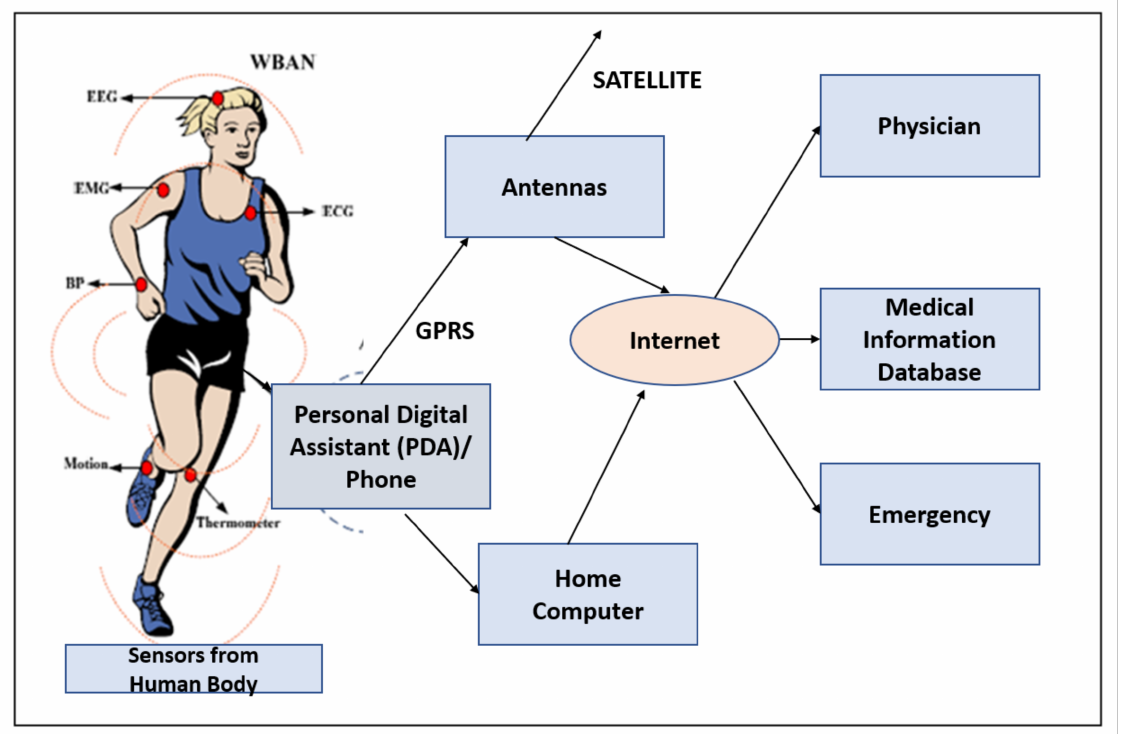
Figure 2. Structure of Body Area